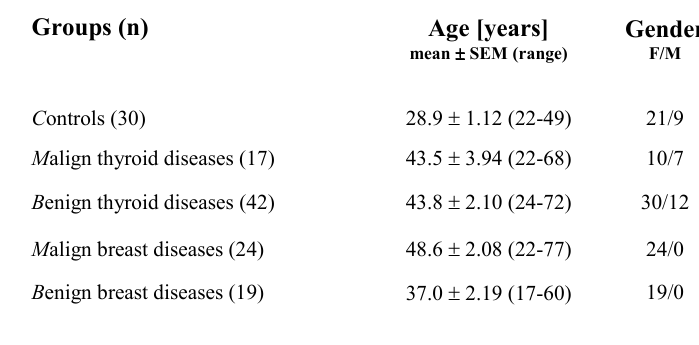
Table 1. Demographics of the controls and the